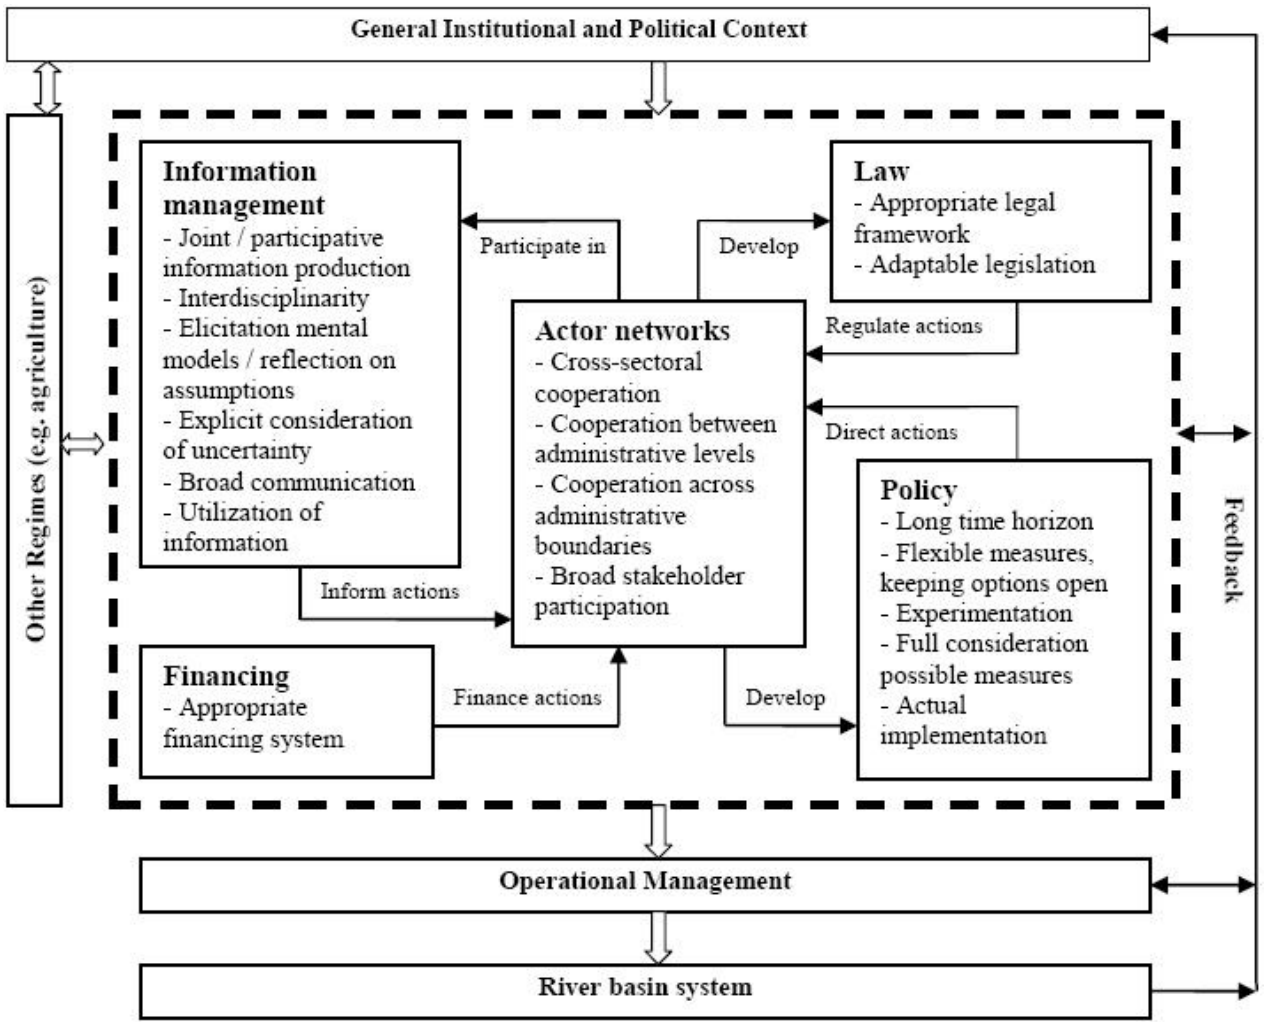
Fig. 2. River basin management regime and criteria for an adaptive